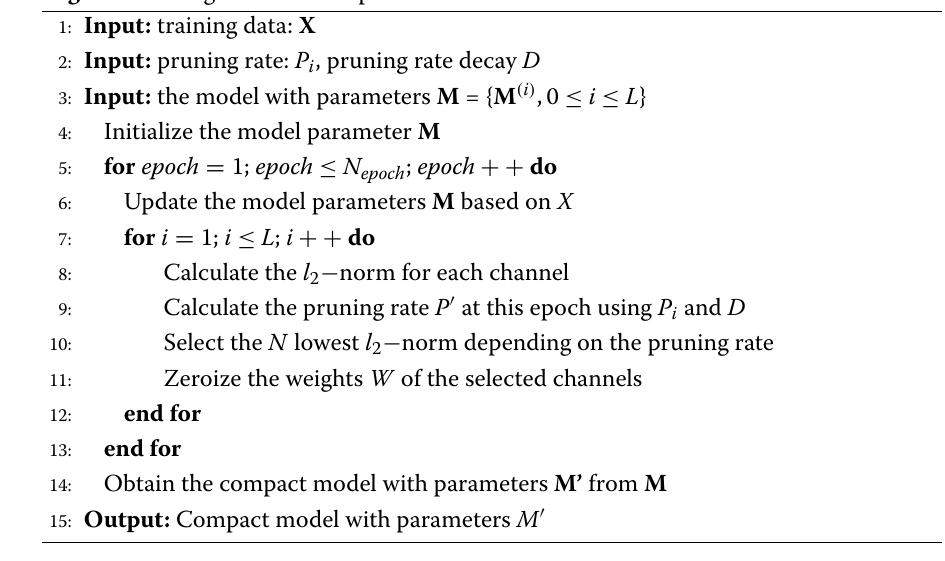
Algorithm 4 Algorithm Description of